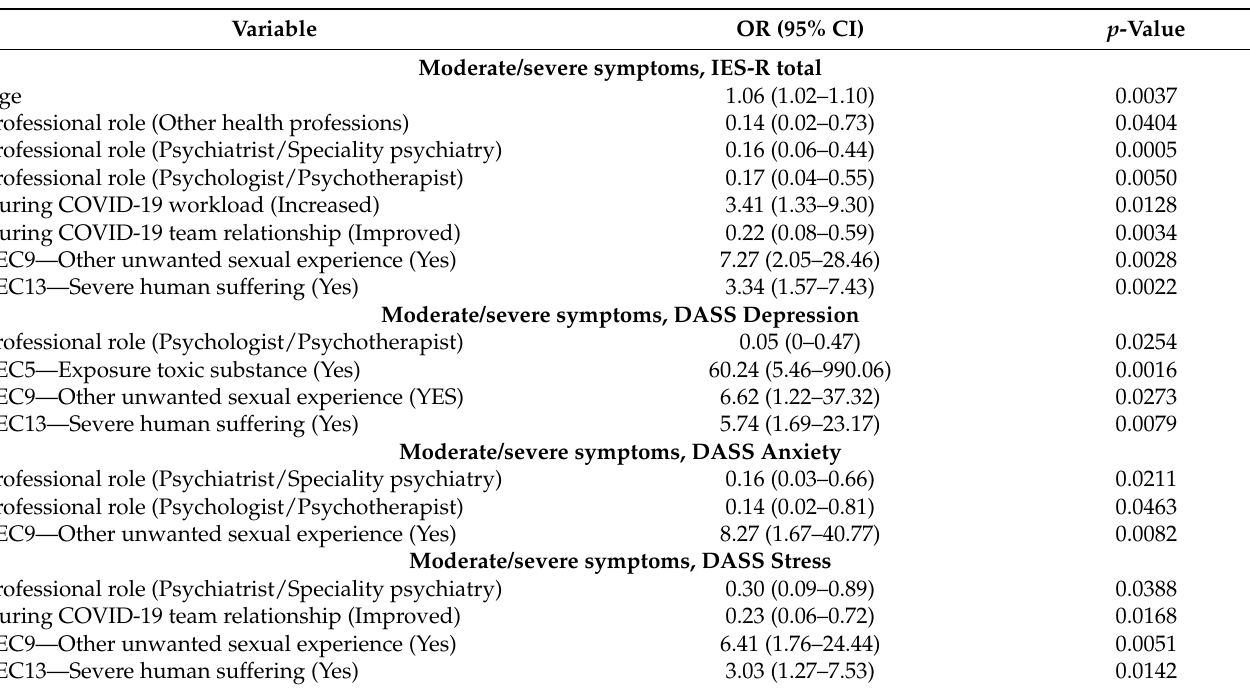
Table 6. Significant predictive factors for moderate/severe symptoms of the outcomes measured (IES-R total, DASS Depression, DASS Anxiety, DASS Stress) identified by multivariable logistic regression